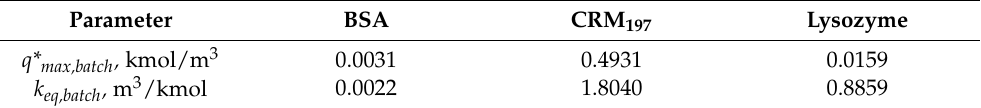
Table 4. Values of model parameter adjusted for batch experiments with the Wang et al.